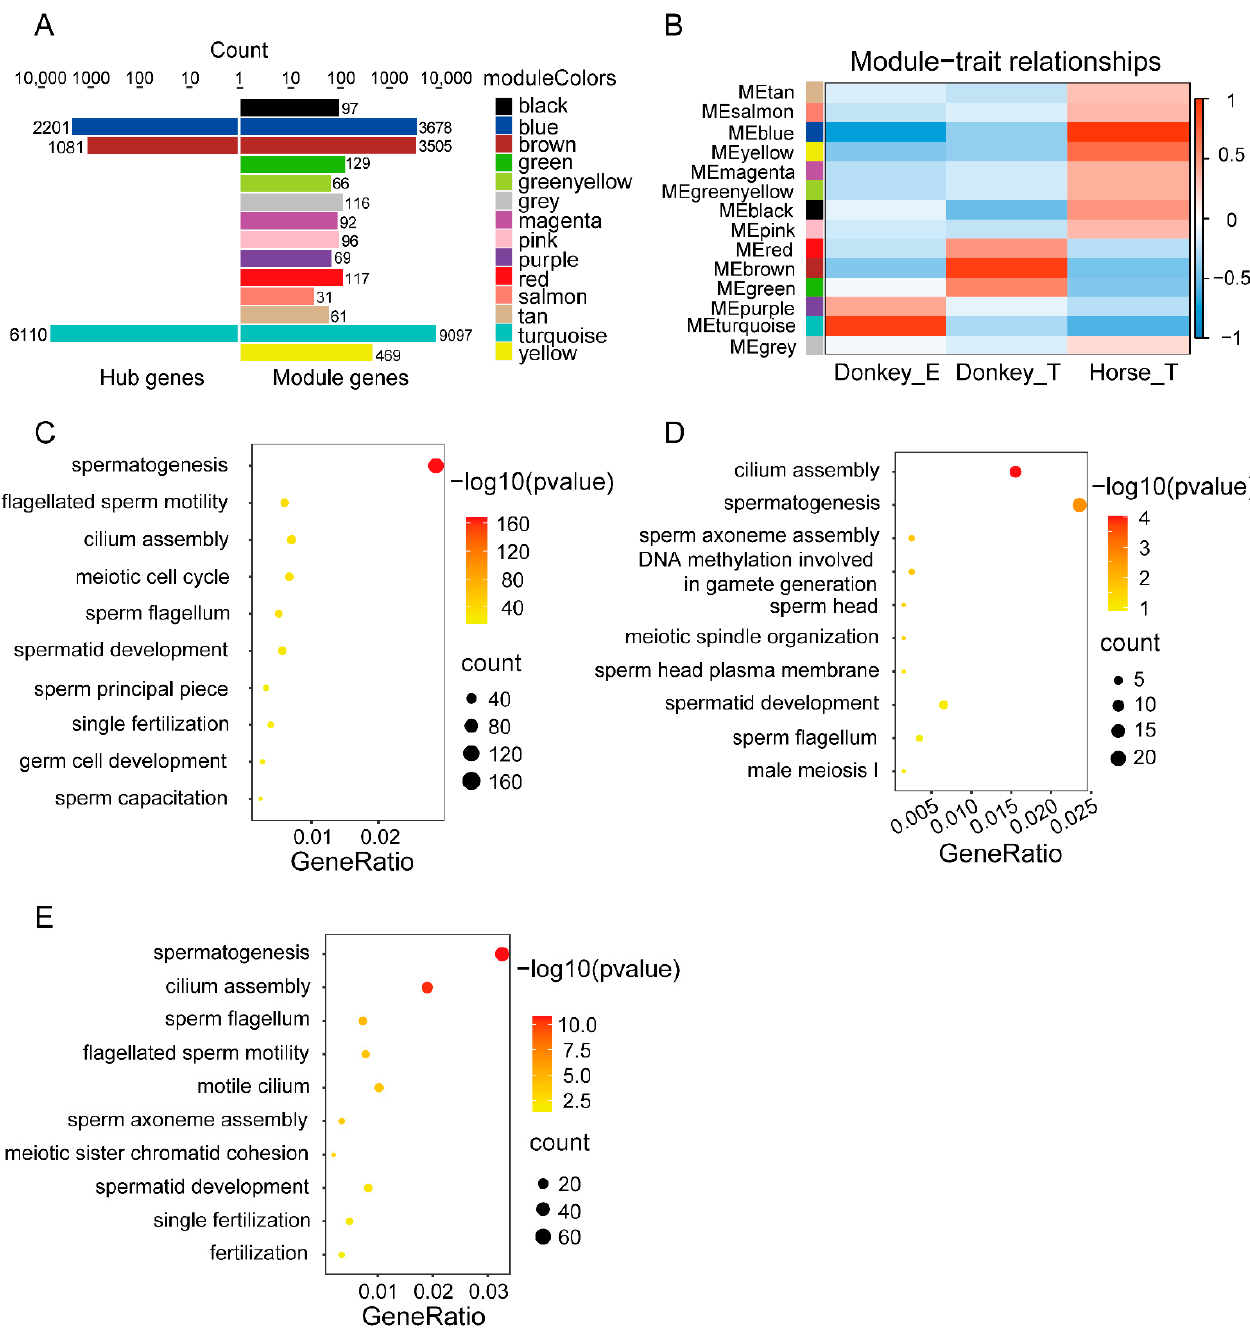
Figure 3. Weighted gene co–expression network analysis (WGCNA) of different tissues. ( A ) The histogram shows the number of genes in the modules identified by WGCNA; the right panel shows the number of genes in the modules and the left panel shows the number of hub genes. ( B ) Heatmap of module–tissue correlations. Red indicates a strong correlation and green indicates a weak correlation. ( C ) Bubble plots represent biological processes enriched by hub genes in donkey epididymal tissue. ( D ) Bubble diagram of biological process enriched by hub genes in donkey testis tissue. ( E ) Bubble diagram showing biological process enriched by hub genes in horse testis tissue.